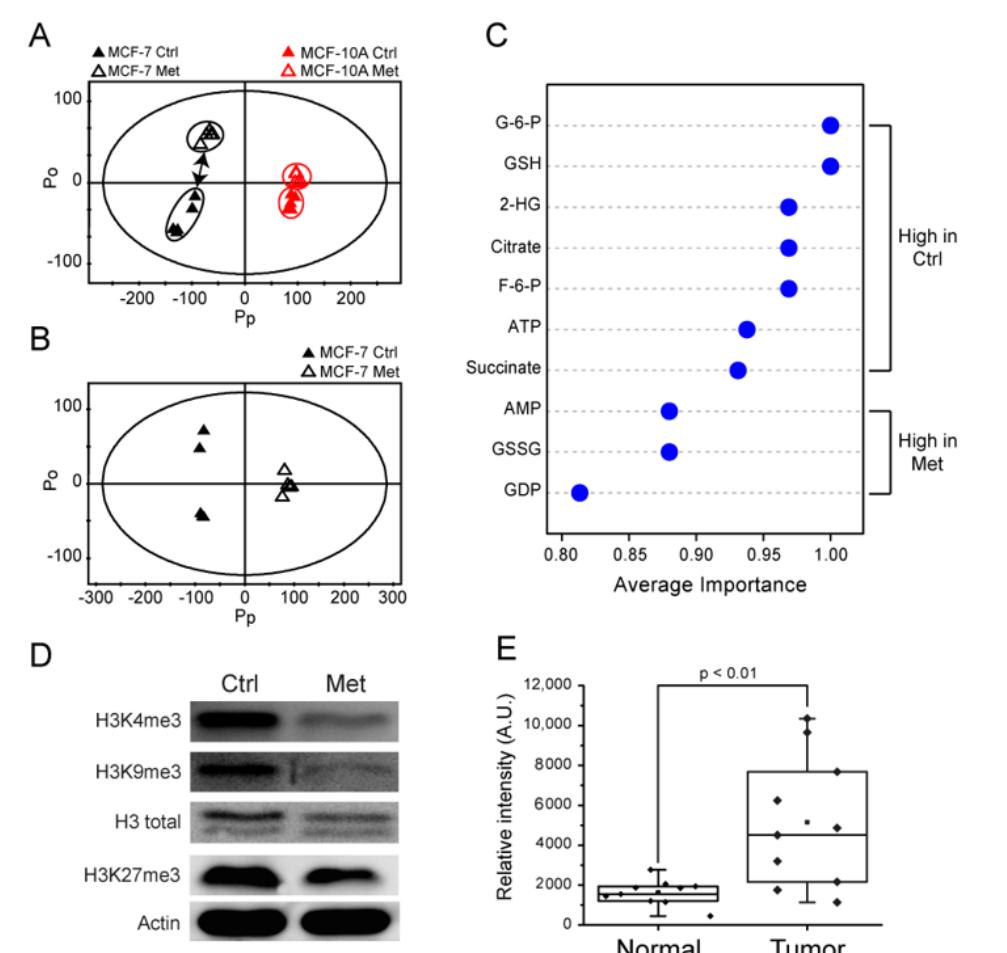
Figure 3. Multivariate analysis on metabolomic changes, histone methylation status by metformin treatment in MCF-7 cells, and the 2-HG level in breast cancer tissues from patients. ( A , B ) NMR metabolomic changes by metformin treatment were analyzed by multivariate analysis. Black symbols: MCF-7; red symbols: MCF-10A; filled symbols: Control (Ctrl) group; open symbols: Metformin (Met) treated group. ( A ) Principal component analysis (PCA) on metformin-treated and control groups for MCF10a and MCF7 cells. ( B ) Orthogonal projections to latent structure-discriminant analysis (OPLS-DA) for control and metformin-treated MCF-7 cells. ( C ) Multiple ROC curve analysis for the significance of contributing metabolites using the quantitative LC/MS analysis. ( D ) The changes in the histone methylation status of MCF-7 cells were measured by Western blot using H3K4me3, H3K9me3, and H3K27me3 antibodies after metformin treatment. The data are representative of three independent experiments. ( E ) The 2-HG levels from paired normal (non-involved) and tumor tissues from breast cancer patients were measured by LC/MS (n = 10 for each